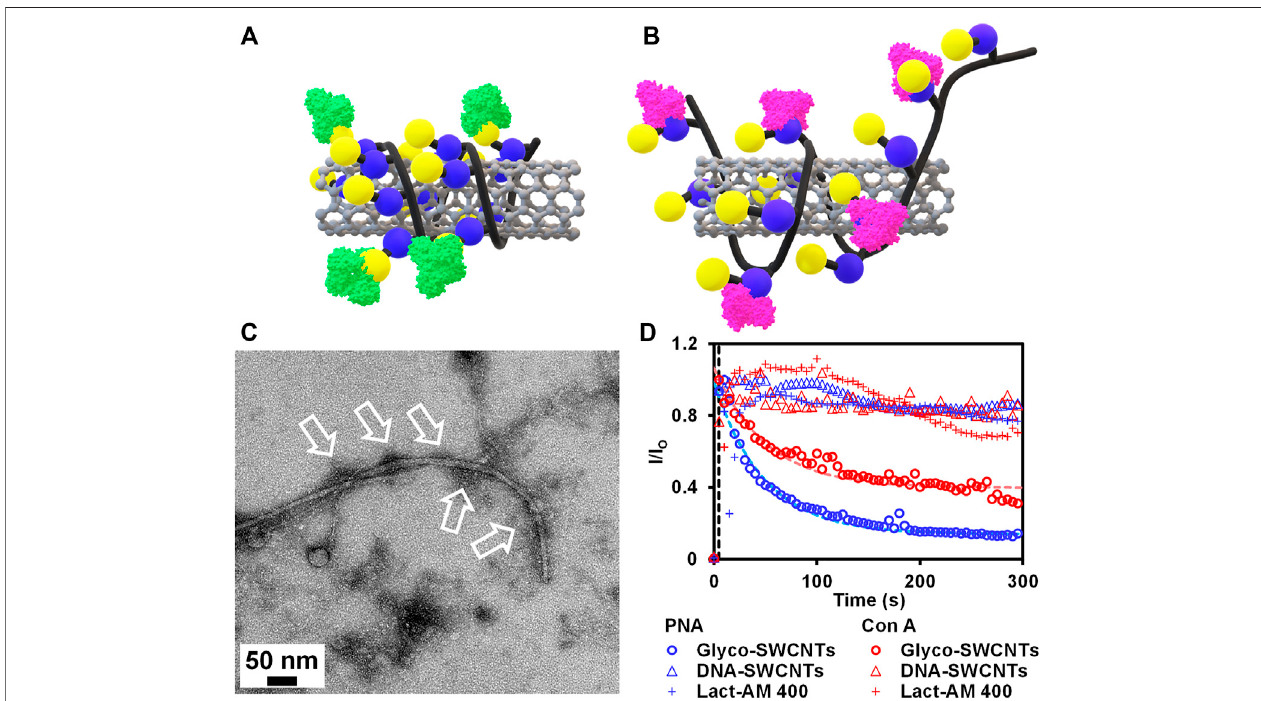
FIGURE 4 | Schematics depicting the binding of (A) PNA to the external Gal group and (B) Con A to the internal Glc group of Lact-homopolymer that is wrapped aroundtheSWCNT. (C) TEMofGlyco-SWCNT sampleat ananotube concentrationof13.74±0.50 μ g/mlafterincubating with26.00±0.05 μ g/mlPNA. (D) Kineticsof lectin (i.e., PNA and Con A, respectively) interaction withGlyco-SWCNTs, DNA-SWCNTs,and Lact-AM400polymer, respectively, that aremeasuredfrom the emission intensity ratio change of lectin FITC marker at 525 nm peak wavelength as a function of time. A fi xed excitation wavelength of 408 nm laser was used for visible fl uorescence spectra